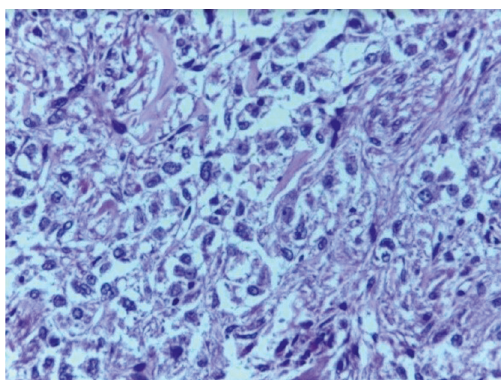
Figure 7: On high magnification, remarkable cellularity, granular cytoplasm, and central or slightly eccentric nuclei are observed. There are no abnormal mitosis and mild nuclear